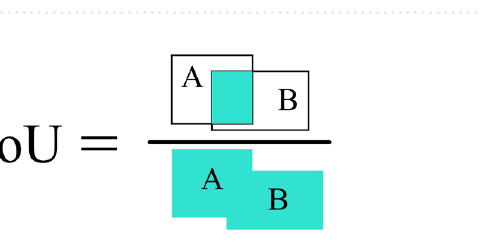
Figure 12. Results of training.